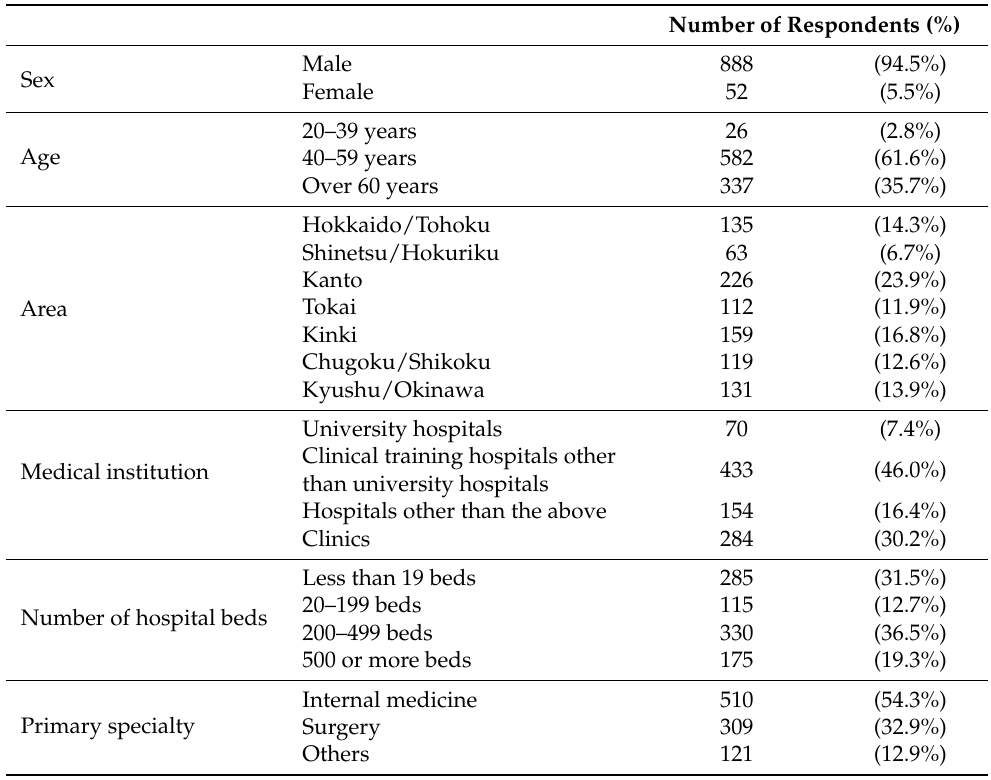
Table 1. Attributes of the respondents and their employing medical